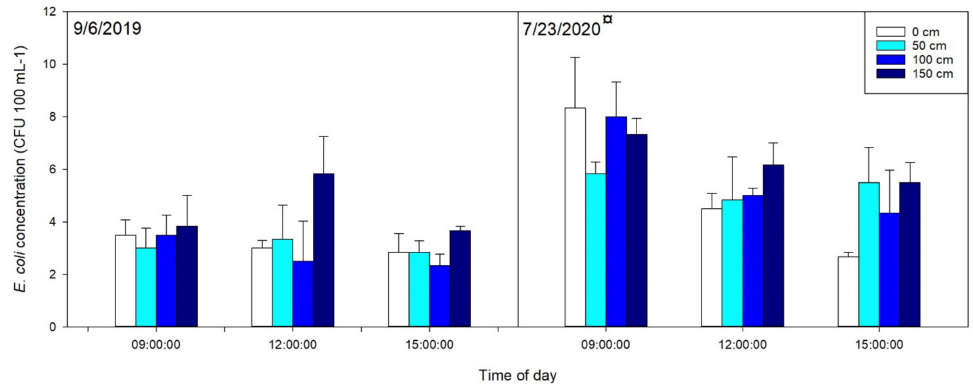
Figure 1. E. coli concentrations measured at Pond 1 on two observation dates. Error bars show standard errors. Dates followed by the symbols ¤ and ‡ indicate statistical significance of the time of day and/or sampling depth, respectively, as a factor as determined by the two-way ANOVA.